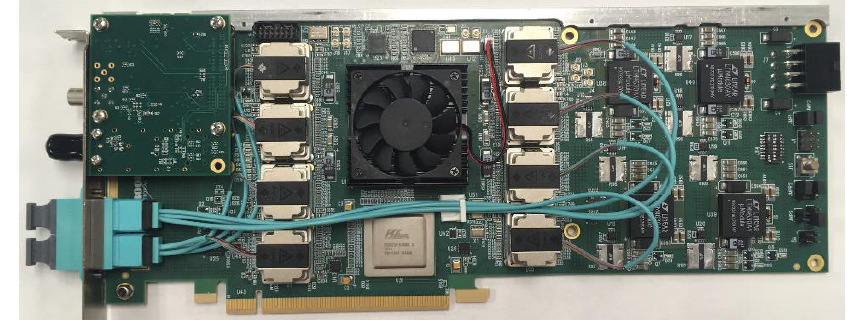
Table 1. Number of FELIX links, cards and FELIX PCs that will be installed during LS2.